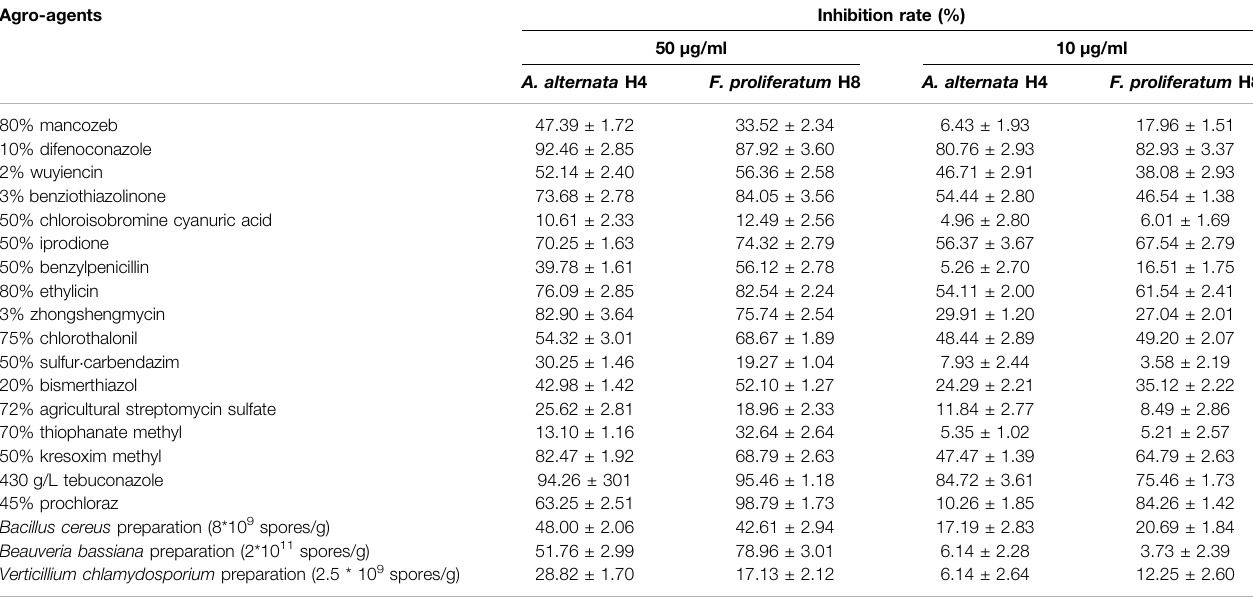
TABLE 2 | Inhibitory effects of 20 agro-agents at the concentrations of 50 µg/ml and 10 µg/ml on A. alternata H4 and F. proliferatum H8. Agro-agents